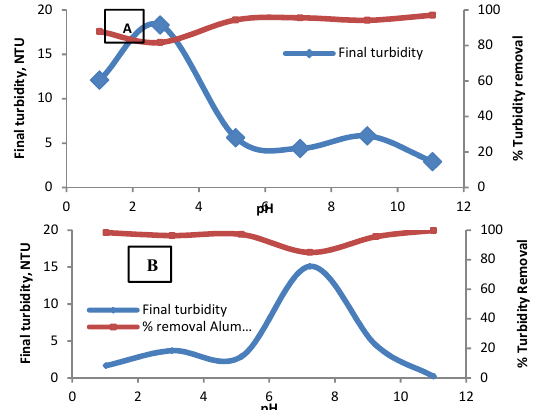
Fig.3. Effect of water pH on removal of turbidity; A: alum, B: Alum + aid. Alum dose is 300 mg/L and COL DOS IS 3 mg/L